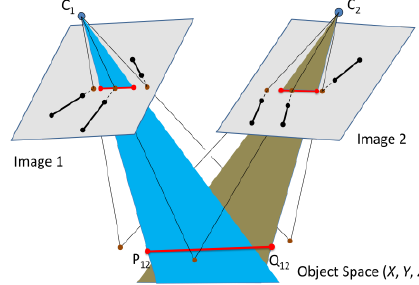
Fig. 3 The reconstruction of the line segments that are nearly- aligned with the epipolar